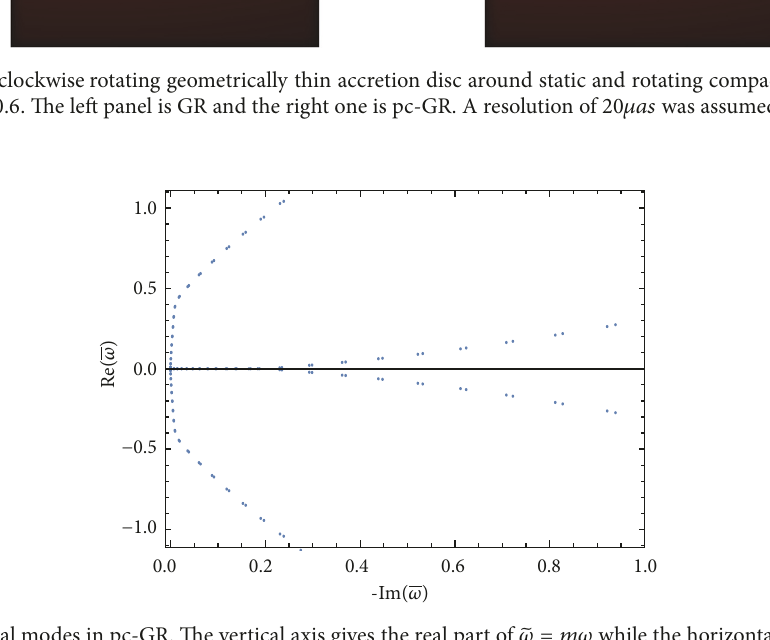
Figure 5: Axial gravitational modes in pc-GR. The vertical axis gives the real part of ̃𝜔 = 𝑚𝜔 while the horizontal axis depicts the negative of its imaginary